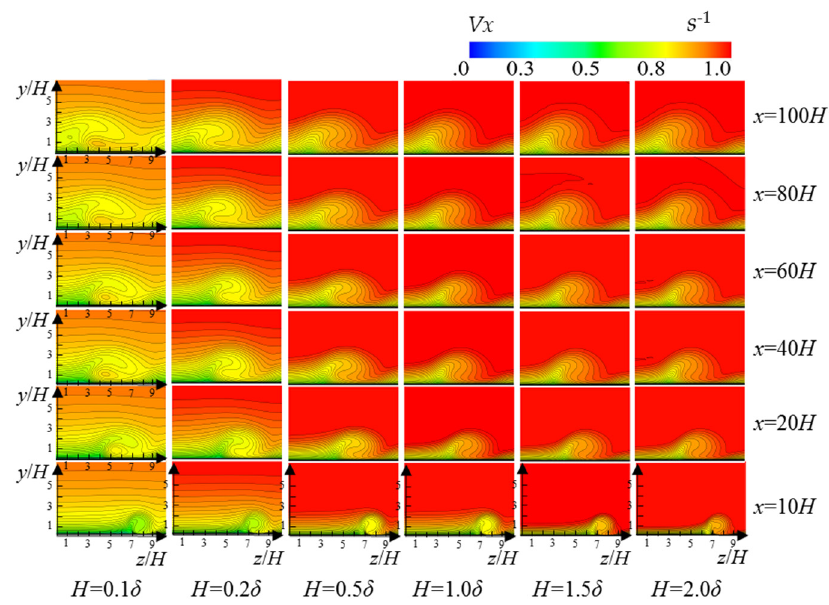
Figure 16. Axial velocity contours downstream of the VG.